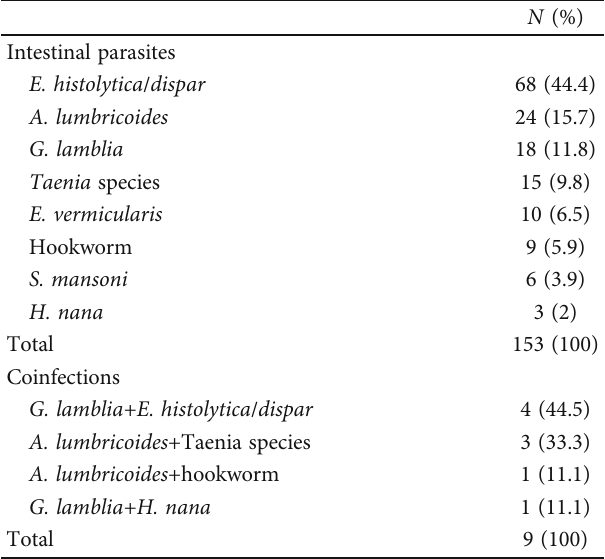
Table 2: Frequency of occurrence of intestinal parasites in 144 positive stool samples and coinfections among pregnant women in Woreilu Health Center, Woreilu, Northeast Ethiopia, from October 2018 to February